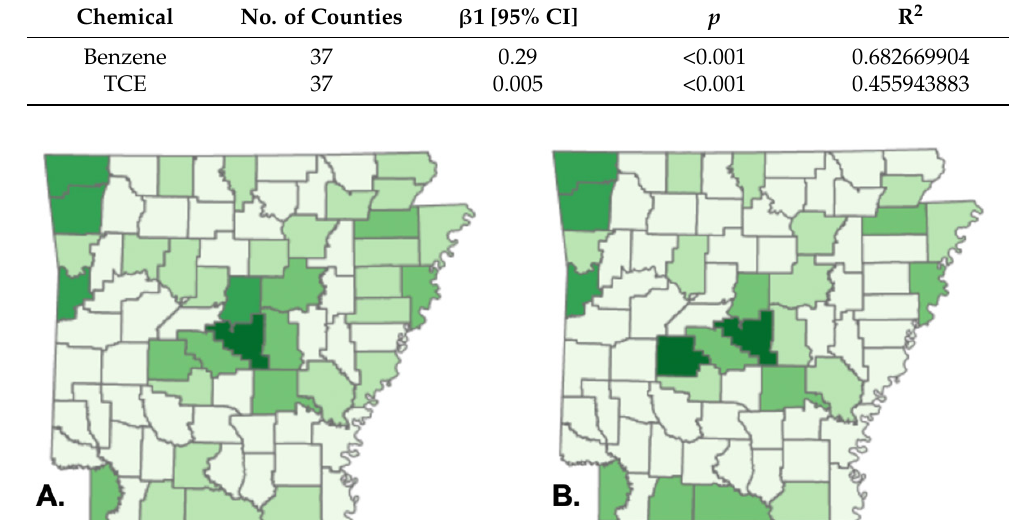
Figure 3. Geographic distribution of Arkansas CTCL patients’ residences by county ( A ) and along major interstates ( B ).